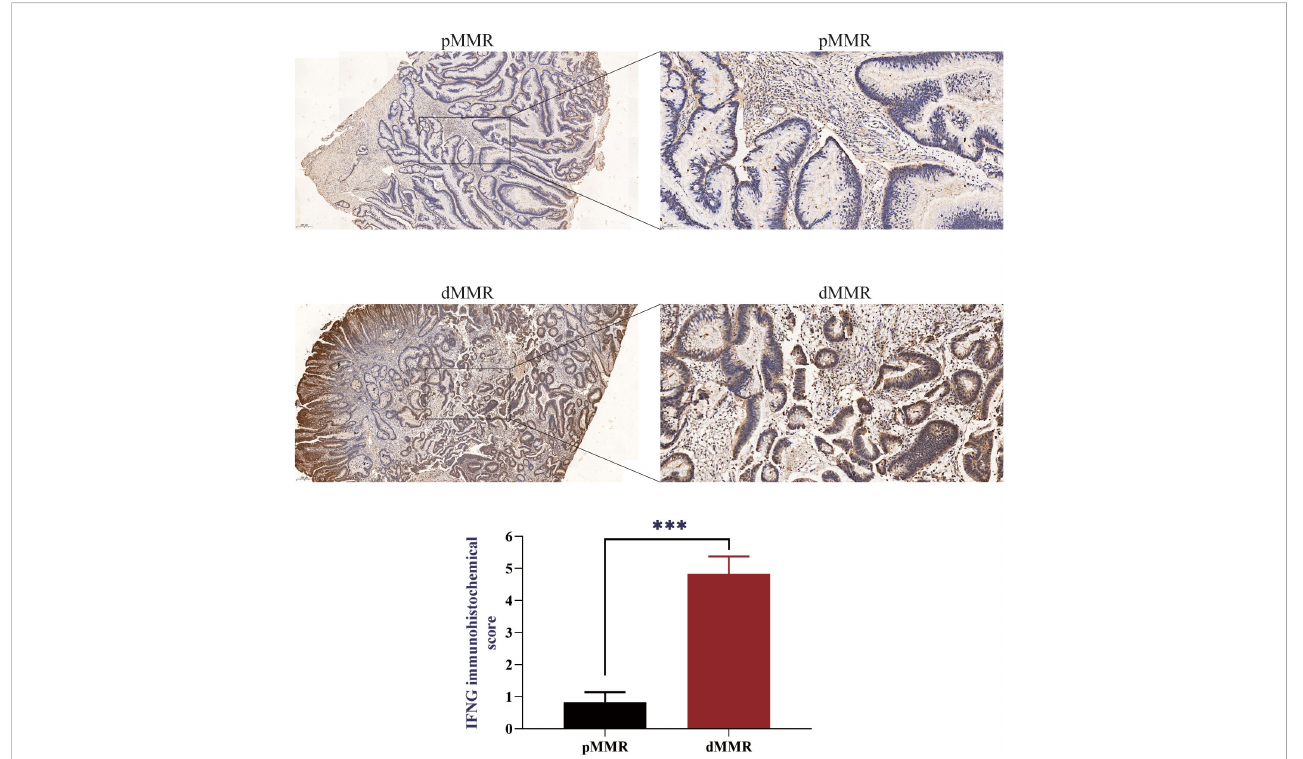
FIGURE 7 IFNG protein expression in pMMR and dMMR tissues. IHC staining showed that IFNG was signi fi cantly up-regulated in dMMR tissues compared with pMMR tissues. (*** P -value <0.001).